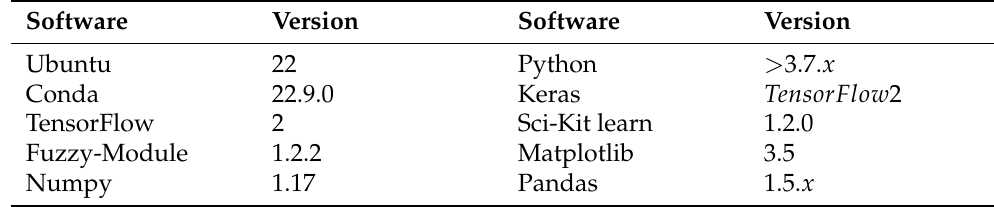
Table 4. System environment and software packages.